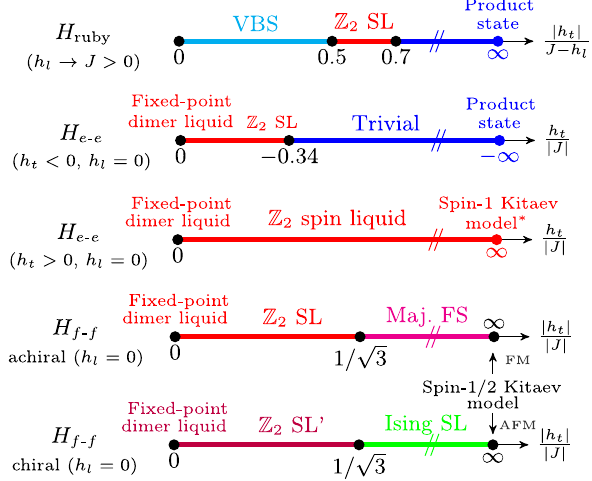
FIG. 4. Phase diagrams for emergent dimer models on kagom´e lattice with fluctuating anyons. We consider the spin- 3 = 2 Ising model on the honeycomb lattice, defined in Eq. (15) with the three different choices of transverse field in Eqs. (16), (18), and 0 gives a degenerate space of dimer coverings (20). Setting h t ¼ on the kagom´e lattice, which is lifted in different ways by h